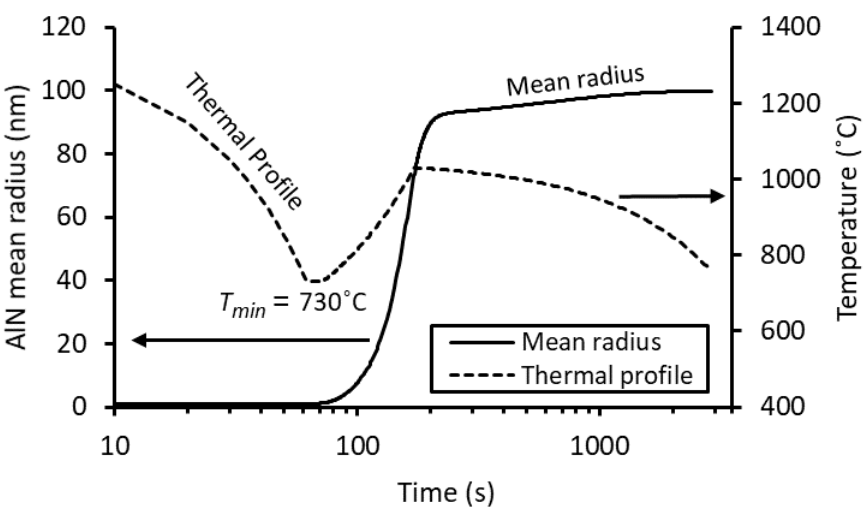
Figure 11. Mean AlN particle radius in ferrite (bcc) predicted by TC-PRISMA [9] for a T min of 730 ◦ C thermal profile to a rebound temperature of 1030 ◦ C and during subsequent secondary cooling.